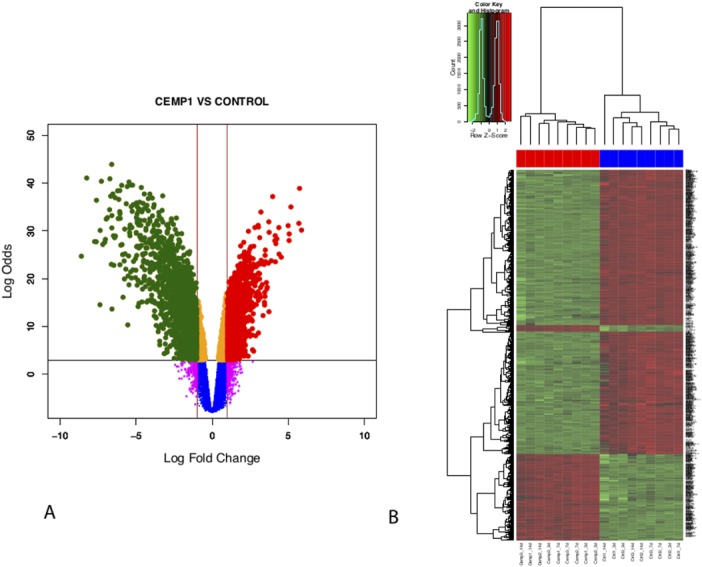
Genome-wide expression profiles HGF-CEMP1 vs. HGF.Total RNA was extracted from HGF and HGF/CEMP1 cell lines. Results from 3 independent experiments were subjected to a microarray analysis. (A). Volcano plot of 1039 differentially expressed genes between HGF-CEMP1 vs. HGF controls. Genes were selected on the basis of the significance of the differential gene expression (vertical red line; P < 0.001) and the level of induction or repression (horizontal red line; fold-change ≥ 2). (B). Heat-map of genes differentially expressed in microarray analysis.